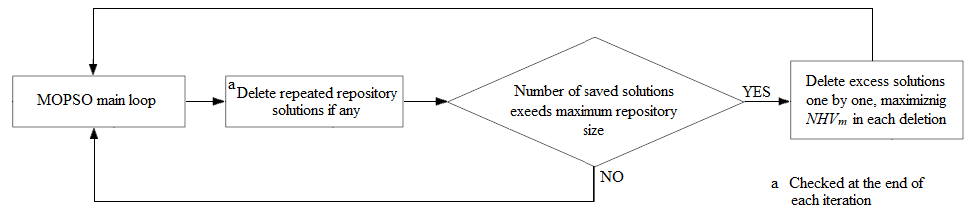
Figure 1. Flowchart describing the repository archiving